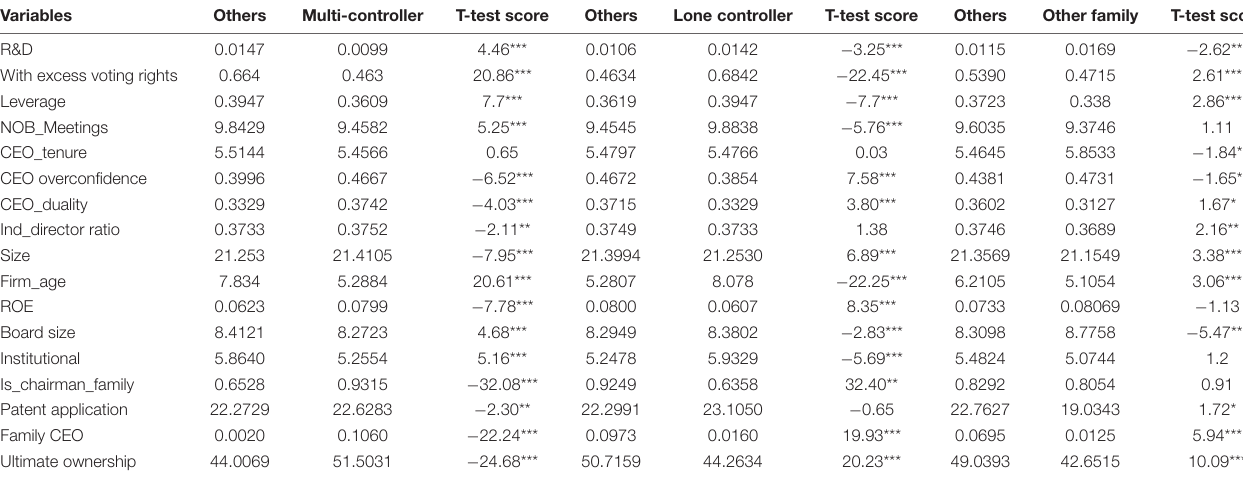
TABLE 2 | Mean comparison test.